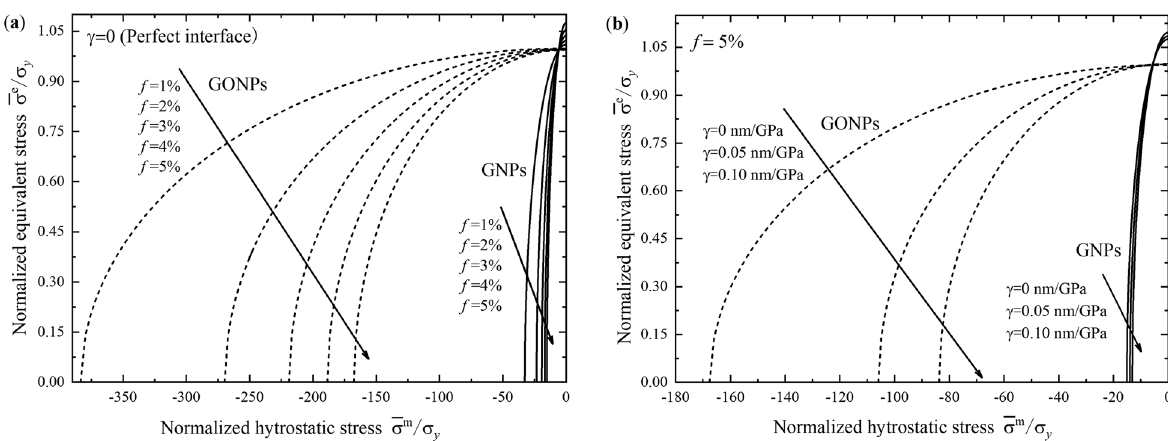
Figure 9: Variations of the normalized yield surface curves of the nanoplate composite with the di ff erent fi ller concentrations ( a ) and the di ff erent interfacial sliding parameters ( b )